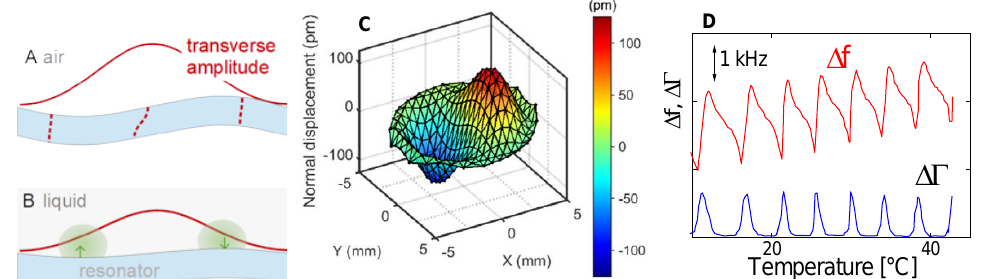
Figure 39. ( A , B ) When a parallel plate experiences a hypothetical pure thickness-shear deformation with in-plane gradients, volume is not conserved at those places, where the in-plane gradient is large. The pure thickness-shear mode therefore is not realized: The plate bends. In liquids, the bending is reduced because the liquid is compressed as well. ( C ) A map of the vertical displacement as determined with laser doppler velocimetry (LDV). Adapted from [172]. ( D ) ∆ f and ∆Γ determined in a temperature ramp. The opposite wall of the liquid cell was parallel to the resonator surface, which generated standing compressional waves with λ depending on temperature. Adapted from